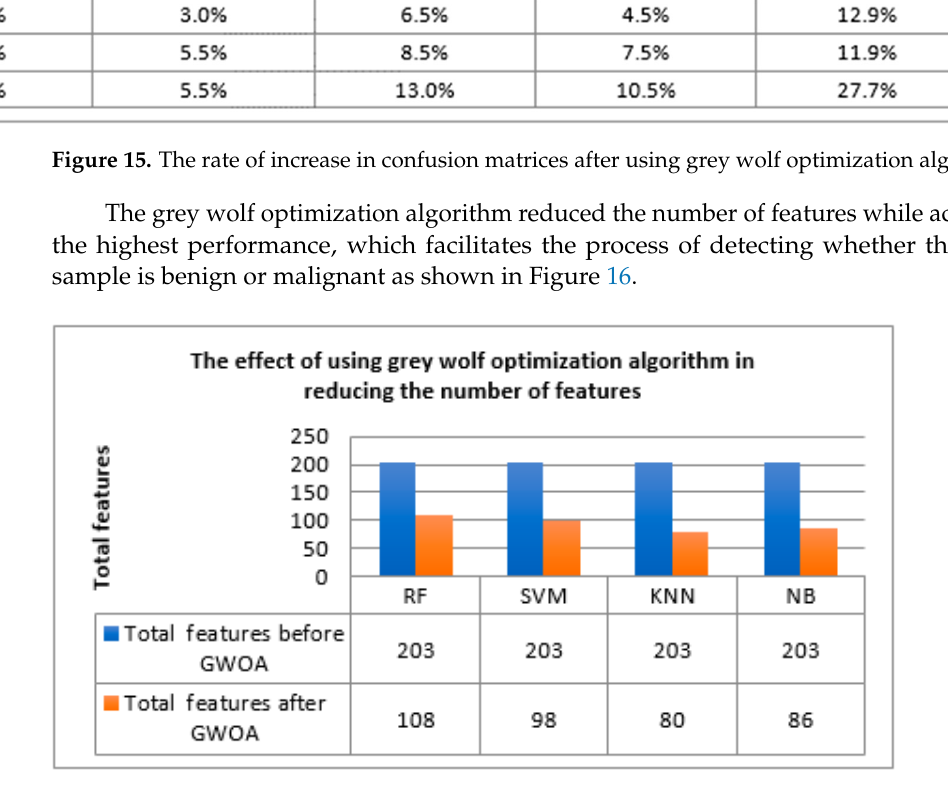
Figure 16. Effect of grey wolf in reducing the number of features.